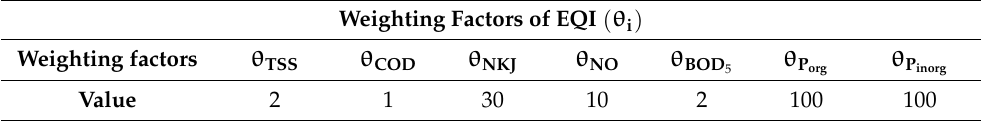
Table 3. Weighting factors for